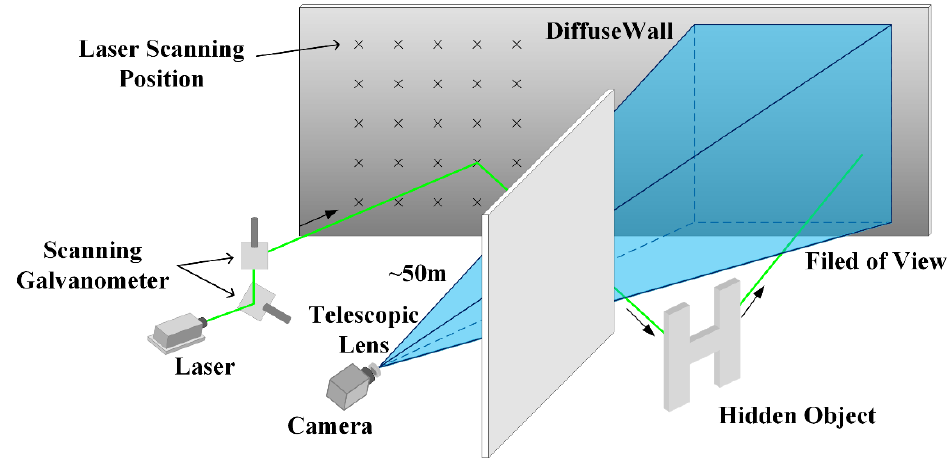
Figure 1. Non-line-of-sight (NLOS) imaging system setup.